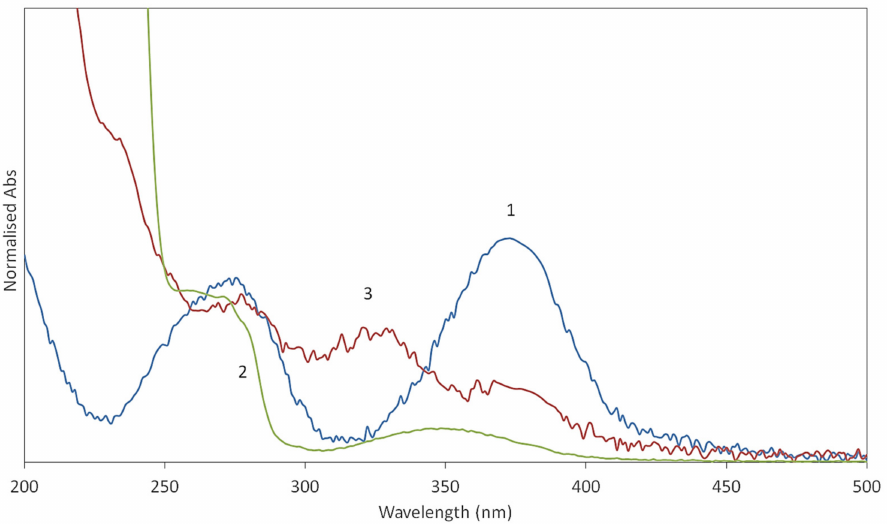
Figure 6. Normalised absorbance vs. wavelength of the selected peaks from Figure 5: solution containing Cr(VI) (peak 1) (blue), extract from leather containing a yellow dye (peak 2) (green), extract from leather containing a red dye (peak 3)